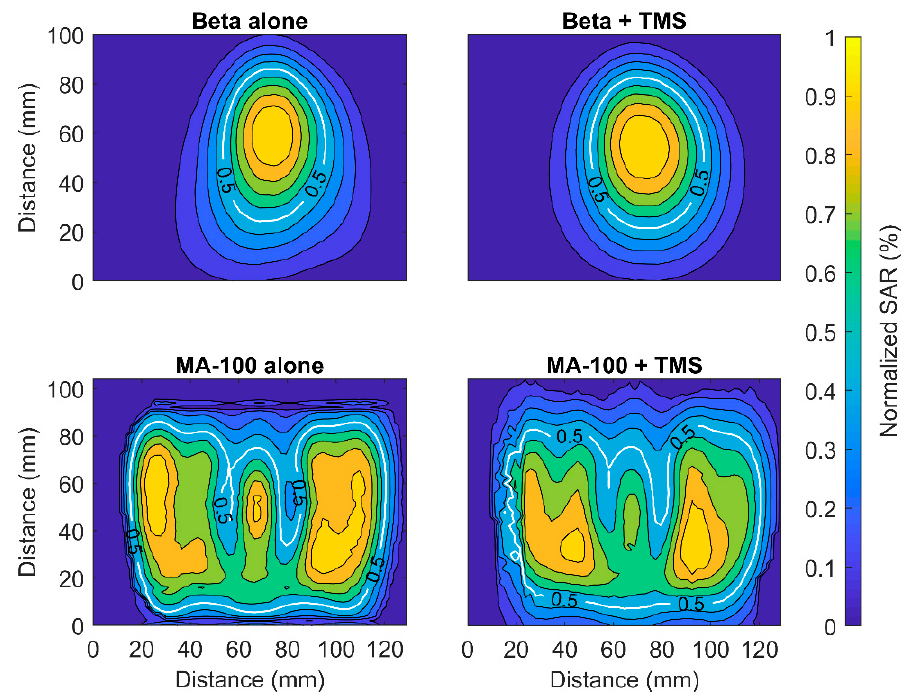
Figure 8. Normalized SAR distribution of the Beta and MA-100 applicators alone (left) and the applicators combined with the thermal monitoring sheet (TMS; right) at 10 mm depth in a liquid muscle-equivalent phantom. The effective field of the applicators is depicted in white.